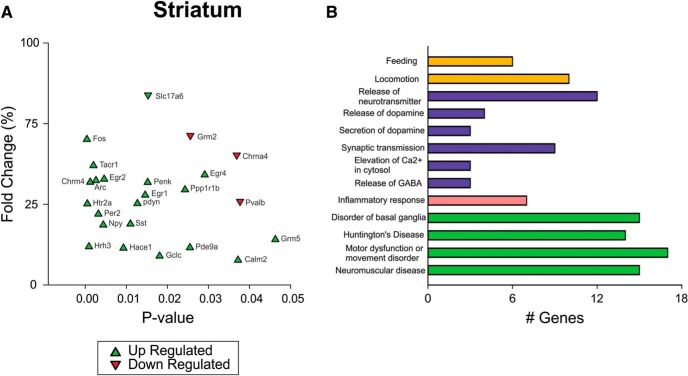
Altered expression level of multiple HD markers in the striatum of the Q175 HD model. A, Differentially expressed genes in the striatum observed between TRF group and ad lib group using NanoString (find all gene expression data in Table 6). The same Q175 mice that underwent activity/sleep monitoring and behavioral tests were allowed to recover for four weeks from manipulations before tissue collection. The signal intensity of individual genes was normalized by adjusting to internal positive standards within each sample (see Materials and Methods). B, Enriched functional clustering in the striatum using the IPA analysis tool (based on data in Table 6; uncorrected Fisher’s exact test p value < 0.05). The clusters of interest with statistical significance are picked and enriched biofunctions in those picked clusters are shown (in descending order of significance). The picked clusters include Behavior (p = 2.72E-17, color orange), Cell-to-cell signaling and interaction (p = 1.02E-17, color blue), inflammatory response (p = 2.87E-04, color pink), and neurologic disease (p = 8.74E-14, color green).